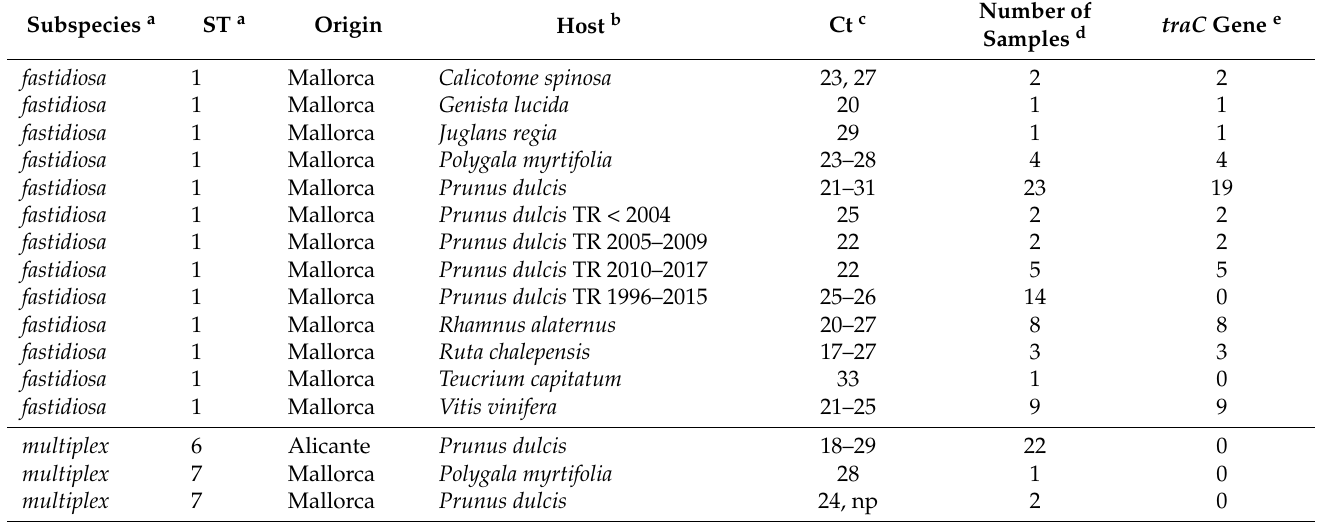
Table 2. Plant samples used in the study naturally infected by X. fastidiosa , with the information of host, geographical origin, and results of amplification of tra C gene, which was used as an indicator of the presence of pXFAS_5235